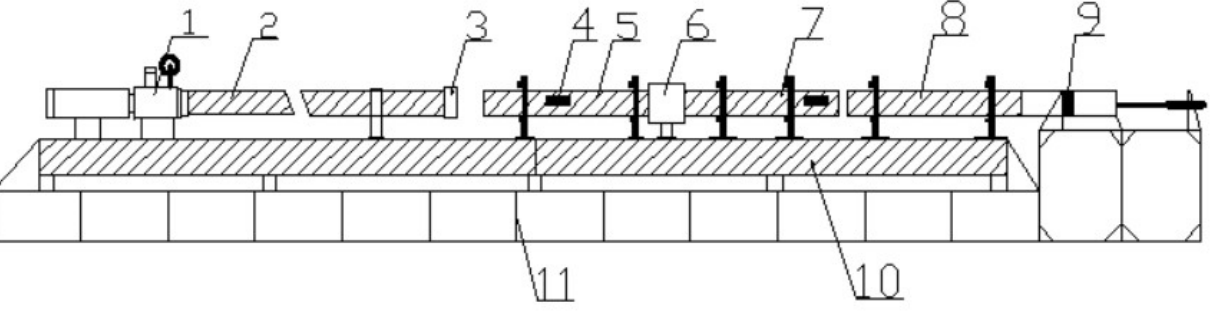
Figure 3. Schematic diagram of the SHPB setup: 1—launcher, 2—launch gun barrel, 3—speedometer, 4—strain gauge, 5—incident bar, 6—sample platform, 7—transmitted bar, 8—damping bar, 9—damper, 10—slideway, and 11—base.